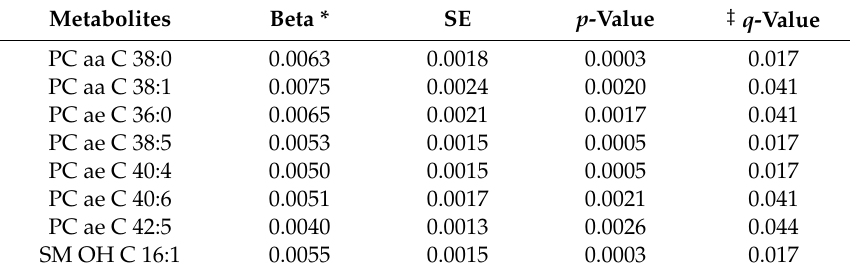
Table 4. Relationship between metabolites and MUFAs intake.